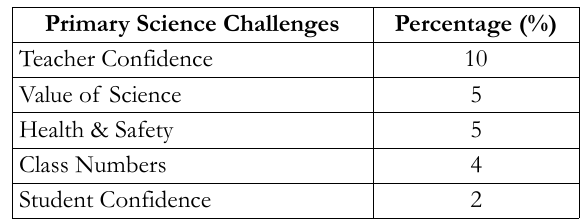
Table 1. Percentage of responses from teachers towards science challenges (Questionnaire)